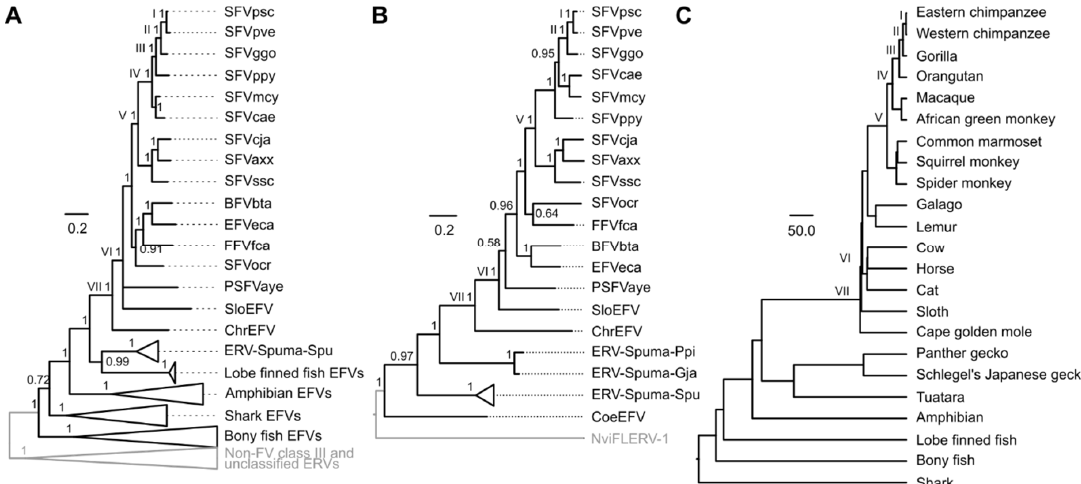
Figure 3. Foamy virus Pol, Env, and host phylogenies. Bayesian Pol ( A ) and Env ( B ) phylogenies were estimated by using MrBayes 3.2.6 [13], and their scale bars are in the units of amino acid substitutions per site. Both Pol and Env trees were rooted by the mid-point rooting method, and the determined outgroups are shown in grey. Arabic numerals on nodes are Bayesian posterior probability clade support values. The topologies of the Pol and the Env trees were compared to that of the host phylogeny ( C ) to identify virus–host co-speciation events labeled with Roman numerals. Nodes on di ff erent phylogenies that are labeled with the same Roman numeral are those corresponding to the same co-speciation event. The timescale of the identified co-speciation nodes, directly inferred from their hosts (Table S5), was used to calibrate the timescales of other nodes. The host tree topology was estimated elsewhere [26], and its scale bar is in units of millions of years. The virus–host association can be found in Table S6. SFV: simian foamy virus; psc, Pan troglodytes schweinfurthii chimpanzee; pve, Pan troglodytes verus chimpanzee; ggo, Gorilla gorilla gorilla; ppy , Pongo pygmaeus orangutan; mcy, Macaca cyclopis macaque; cae, Chlorocebus aethiops Grivet; cja, Callithrix jacchus marmoset; axx, Ateles spider monkey; scc, Saimiri sciureus squirrel monkey; ocr, Otolemur crassicaudatus brown greater galago; BFVbta, bovine foamy virus Bos taurus; EFVeca, equine foamy virus Equus caballus; FFVfca, feline foamy virus Felis catus; PSFVaye, prosimian foamy virus aye-aye; EFV, endogenous foamy virus; SloEFV, sloth EFV; ChrEFV, Cape golden mole EFV; CoeEFV, Coelacanth EFV; NviFLERV-1, Notophthalmus viridescens foamy virus-like endogenous retrovirus - 1.